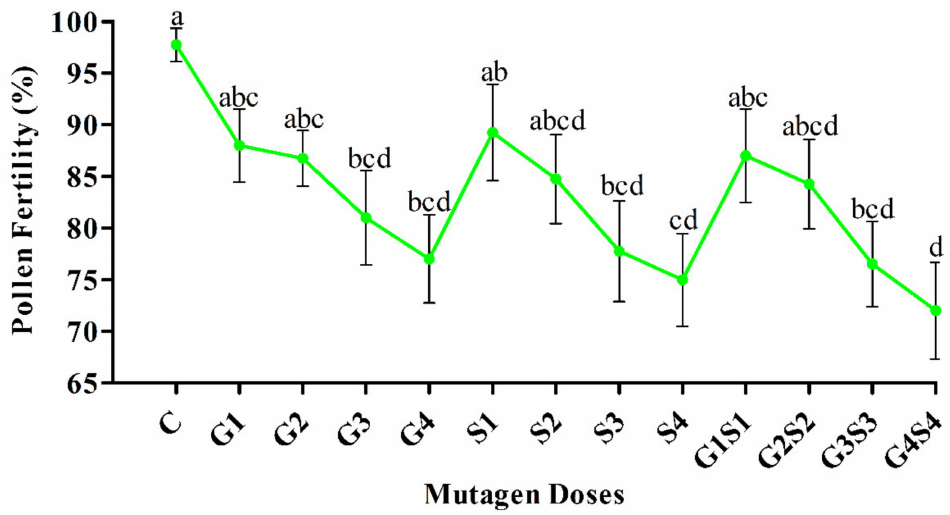
Figure 4. Effects of different doses of γ rays and SA on the pollen fertility in var. Pusa-578. The data is presented as percent (n = 400) and standard error. Line graphs with the same letters are not significant at a 5% level of significance, based on the Duncan’s multiple range test